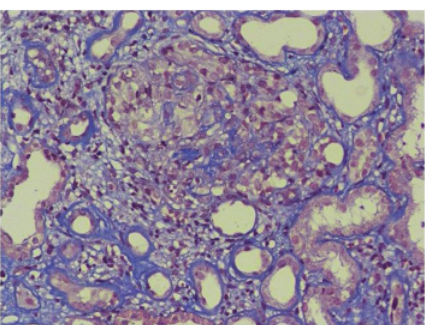
Figure 3: Another section with trichrome staining showing single glomerulus with segmental endocapillary proliferation, fibrinoid necrosis, and breakage of bowman’s capsule along with leukocytic